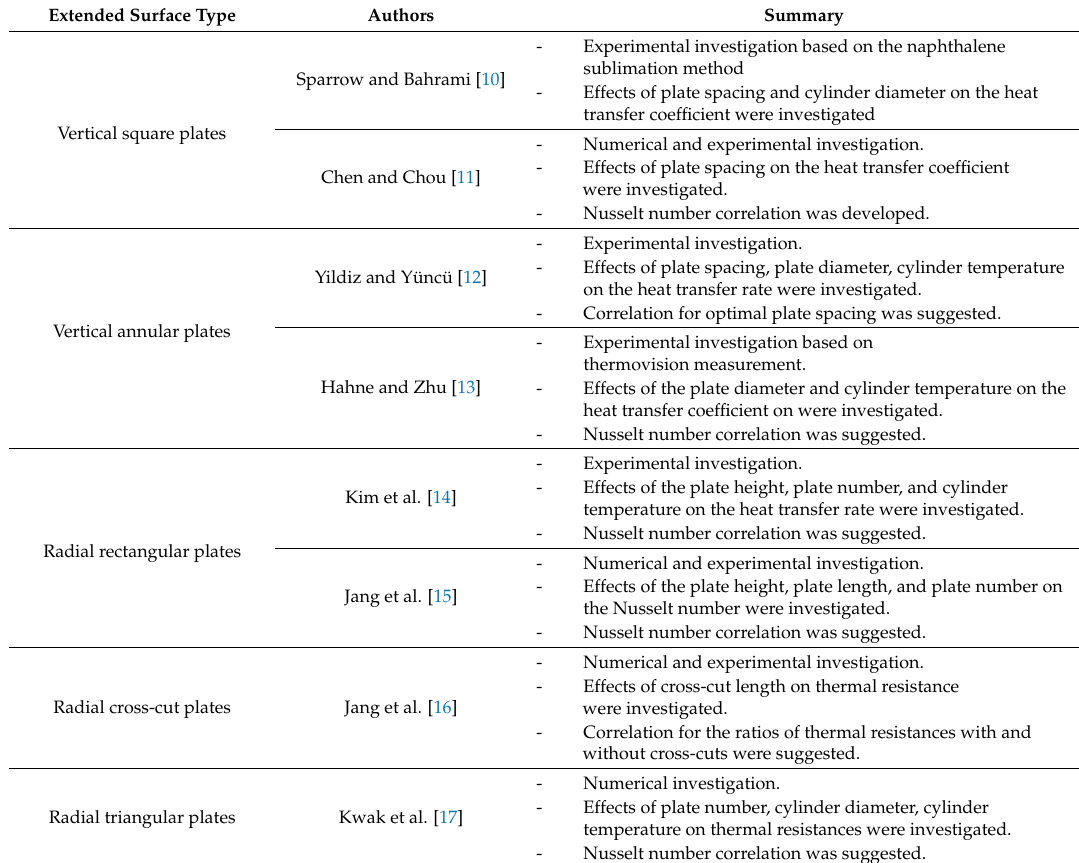
Table 1. Summary of previous research works on extended surfaces on horizontal